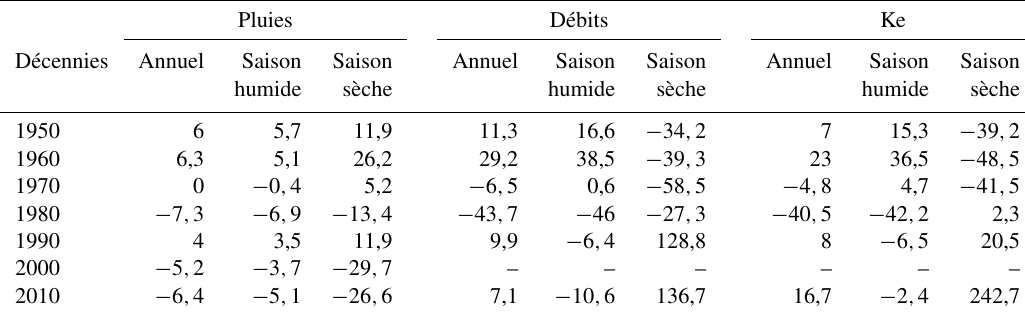
Tableau 1. Ecarts (%) des moyennes décennales annuelles et saisonnières des pluies, débits et coefficients d’écoulement par rapport à leurs moyennes climatologiques sur le bassin de la